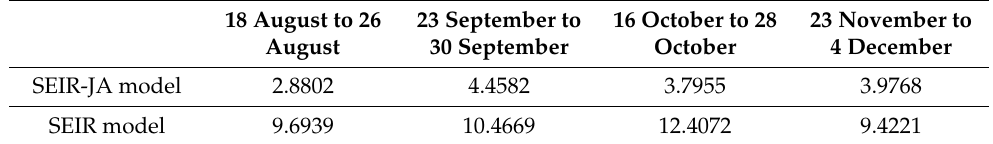
Table 6. Root mean square